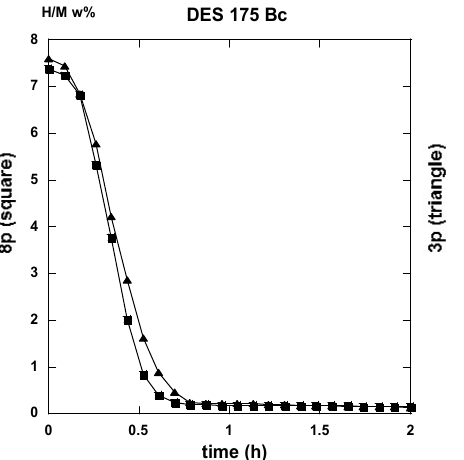
Figure 27. Hydrogen desorption rate (H/M w%) of samples ECAP-treated at 175 °C—2 passes (triangles) and 8 passes (squares).